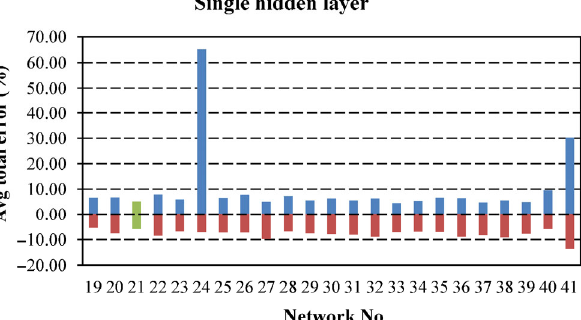
Fig. 12 Average total error% of wear for SHL-ANN archi- tecture (Network Nos. 19 − 41).